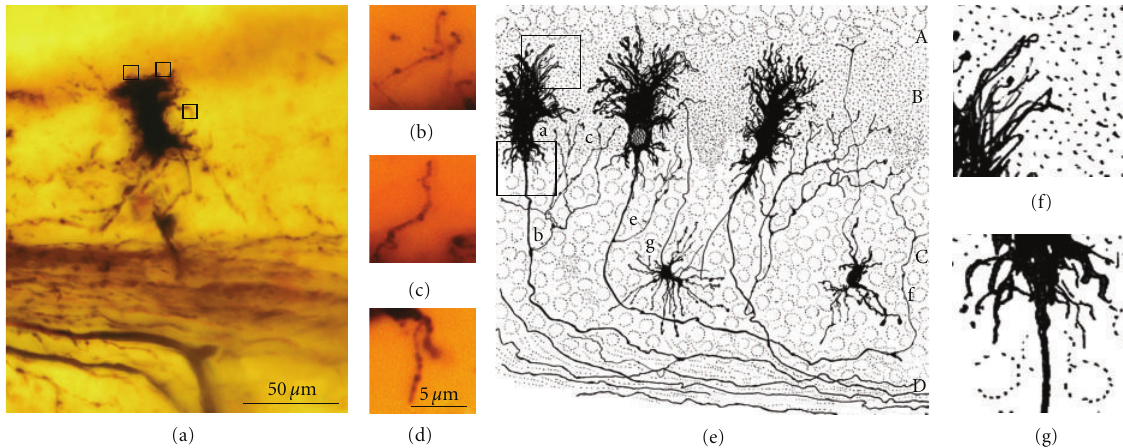
Figure 8: (a) Shows a Purkinje cell in the phase of dendritic disorientation, cerebellum, new-born dog. Cajal histological preparation, Golgi method. Boxed regions show collateral filopodia (b) and terminal ones (c, d). (e) Cajal scientific drawing [7, Figure 416]. Purkinje cells, several days-old dog. Boxed areas (f, g) show digitally enlarged filopodia.